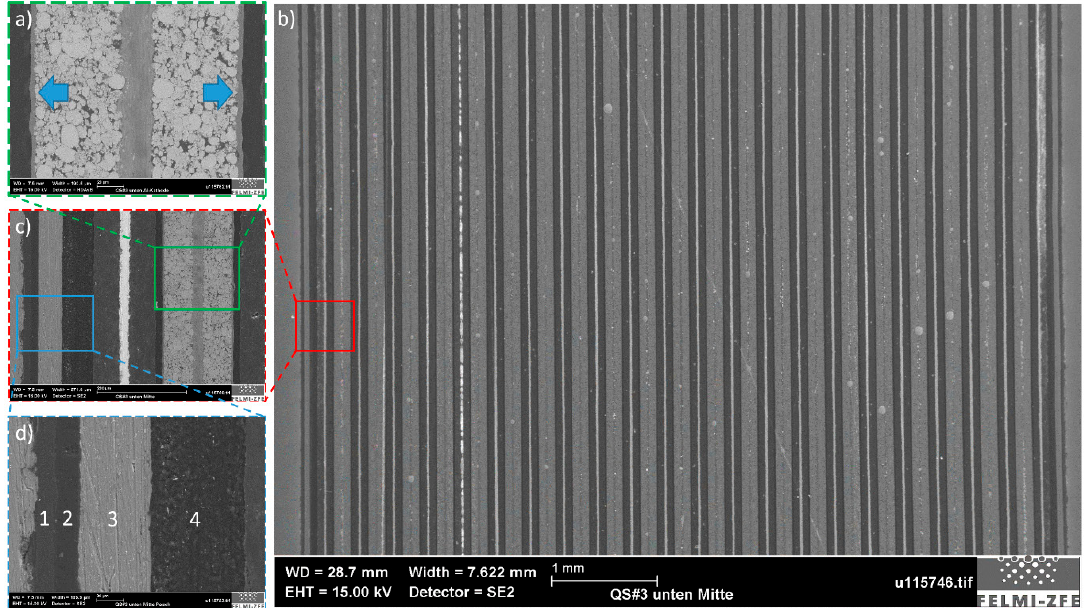
Figure 6. Imaging results of Sample #3. ( a ) Closer view of the battery cathode, where a small 3 µm layer is visible on both sides of the active material; ( b ) battery layer arrangement; ( c ) closer look at battery anode, cathode, separator, and pouch; and ( d ) the four-layer battery pouch, consisting of one Al layer (3) and three carbon oxide layers (1, 2, and 4).